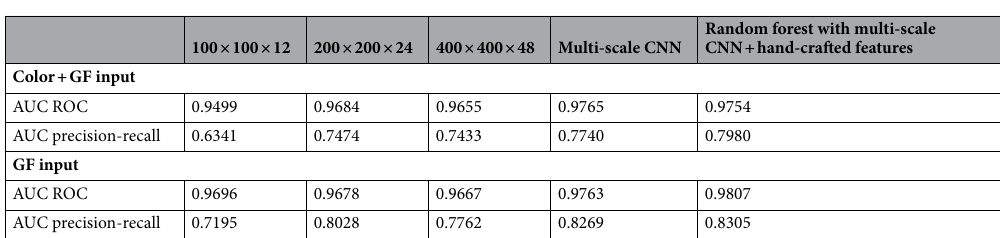
Figure 6. Representative cancer positive and negative candidates. The input from three scales having different volumes of view are presented in three columns with left to right as 100 × 100 × 12, 200 × 200 × 24, and 400 × 400 × 48. GF images are volume rendered visualizations, and color anatomy images are the central 2D slice from the 3D volume. The two positive candidates are from lung and liver, respectively. The two negative candidates are from bile duct in liver and food remnant in GI tract, respectively.